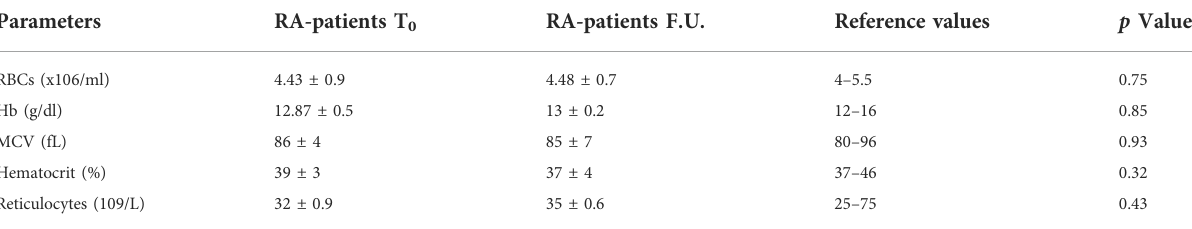
TABLE 4 Erythroid parameters of RA